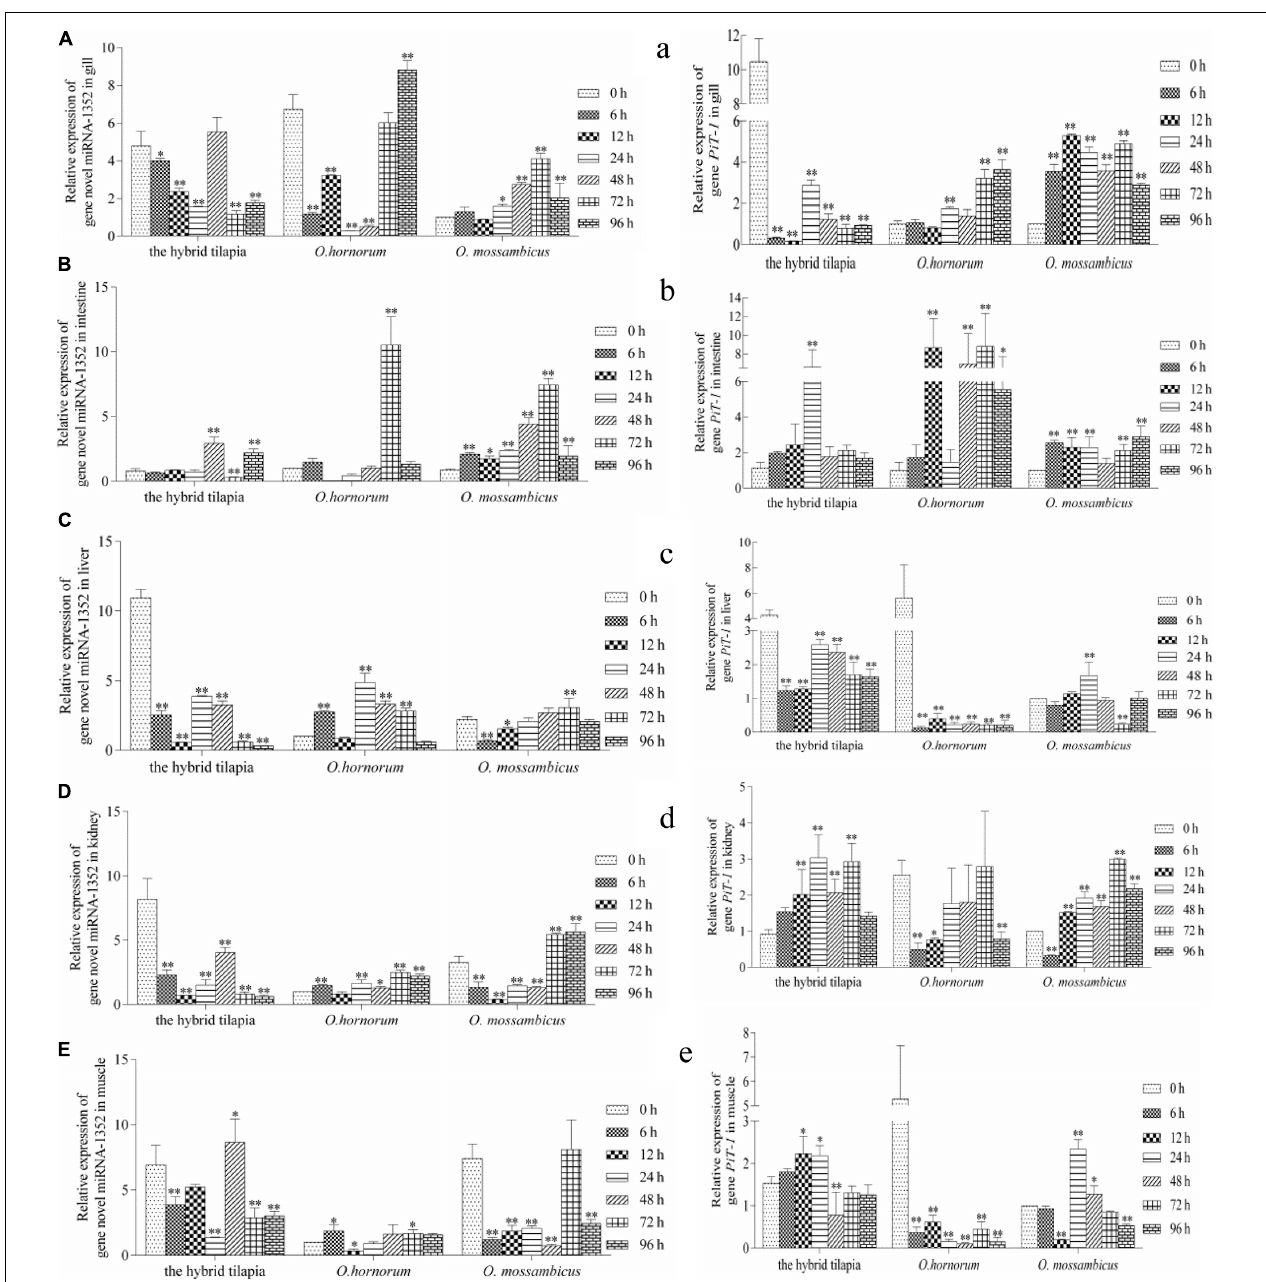
FIGURE 7 | Expression levels of selected novel miRNA-1352 (A–E) and its target gene PiT-1 (a–e) in the control group (C group) and alkalinity stressed group (A group) in the hybrid tilapia and its parent samples for 96 h. “ ∗ ” and “ ∗∗ ” indicate significant differences ( P < 0.05 and P < 0.01, respectively) between values obtained pre-(0 h) and post-alkali stress (6, 12, 24, 48, 72, and 96 h), by paired-samples t